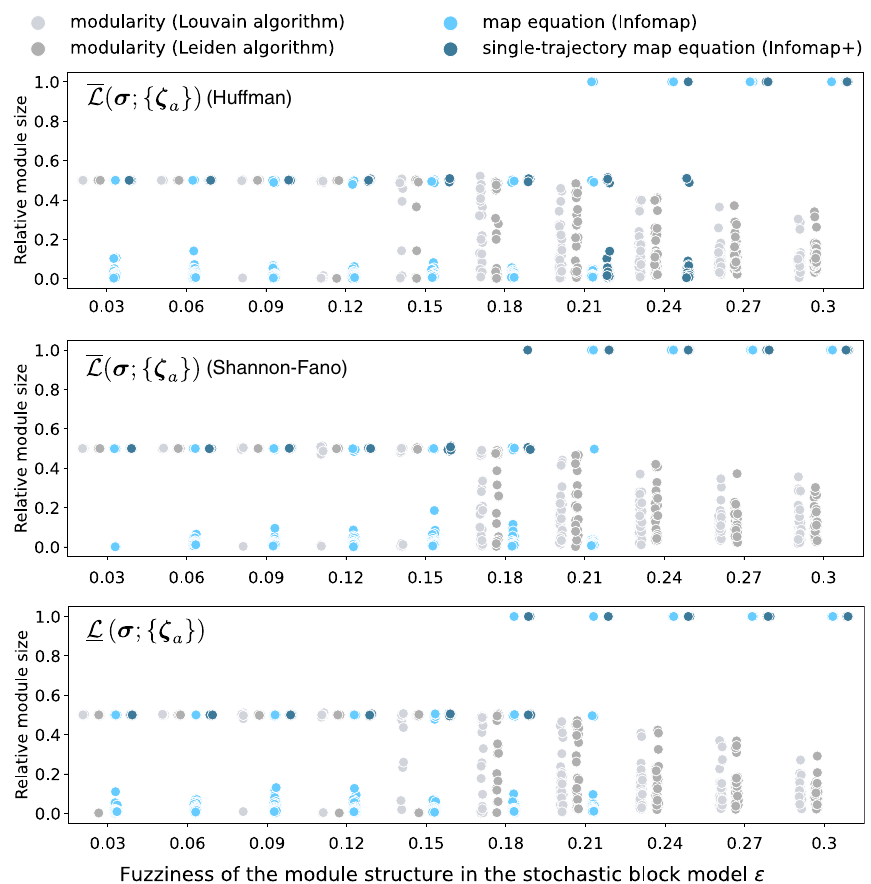
Figure 4. Performance of modularity maximization methods (the Louvain and Leiden algorithms), Infomap ( - -two-level ), and algorithms for the single-trajectory map equation based on L ( σ ; { ζ a } ) σ ; { ζ a } and L (“Infomap+”) on the symmetric SBM ( N = 1, 000 , c = 12 ). We generated five instances (cid:31) (cid:30)